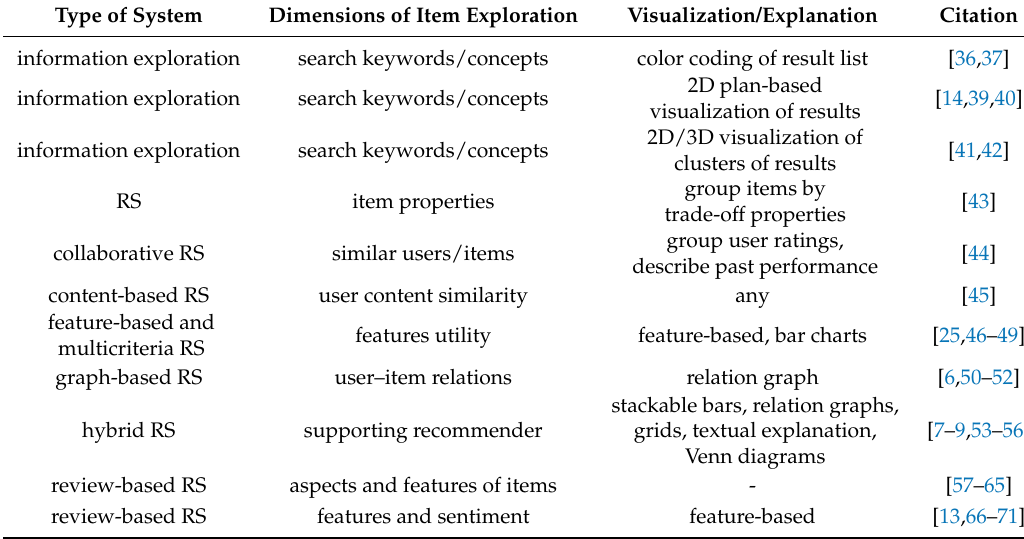
Table 1. Overview of the support to the analysis of results offered in the information exploration and recommender systems (RS)